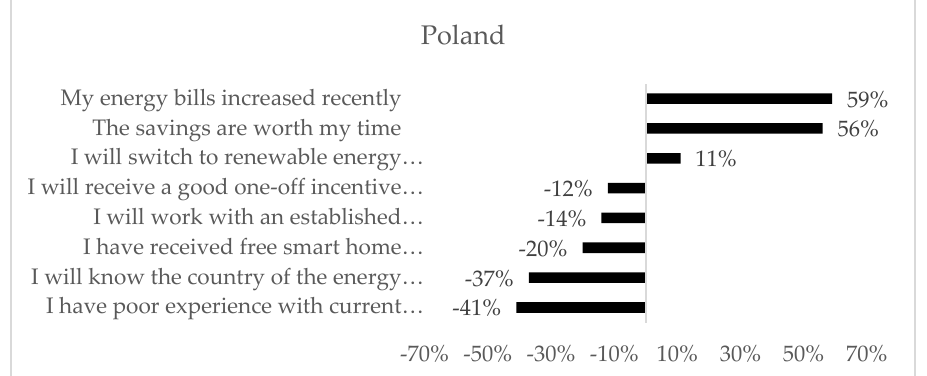
Figure 6. Utility attributes for various energy provider reasons in Australia . Source: own study.